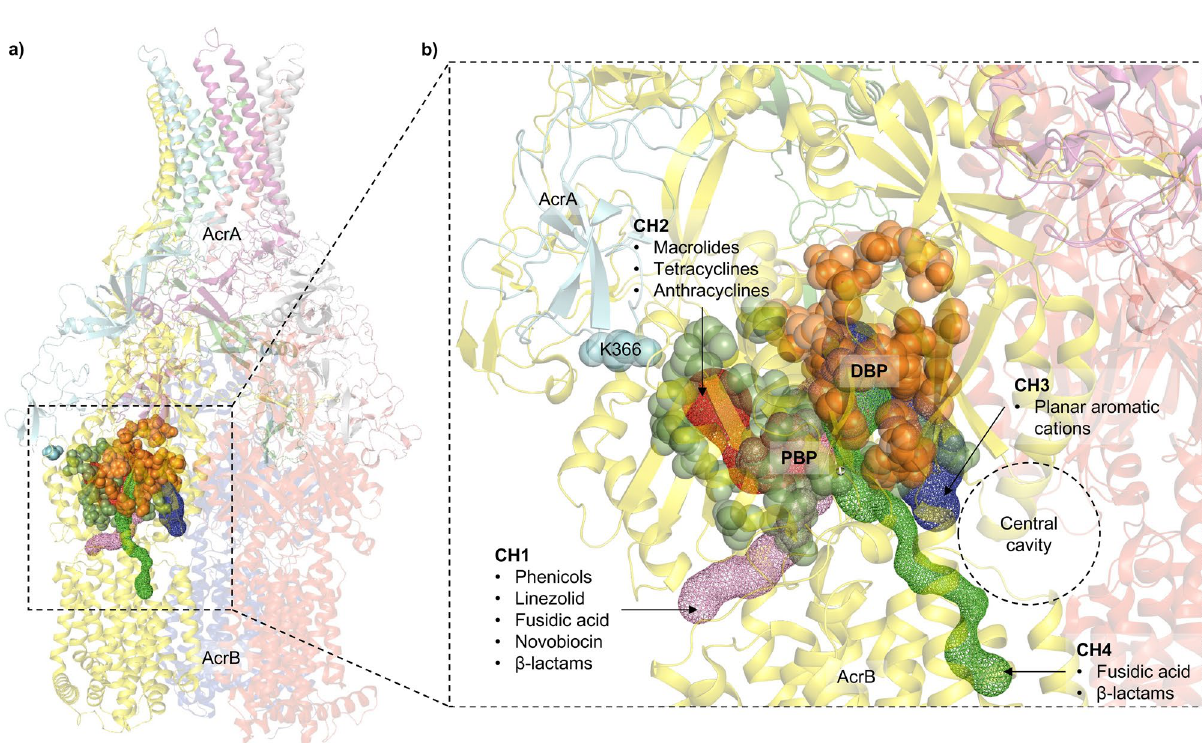
Figure 4. ( a ) The crystal structure of the trimeric AcrB transporter and the hexameric AcrA assembly (TolC not shown for clarity). The different substrate entry pathways are shown as coloured channels, and the binding pockets are indicated by coloured spheres. ( b ) Zoomed-in view of the substrate channels and the binding pockets relative to K366 of AcrA. The green and orange spheres correspond to the space-fill representation of the residues lining the proximal binding pocket (PBP) and the deep binding pocket (DBP), respectively. K366 is in the membrane-proximal domain of AcrA and impacts the residues lining the PBP and the entrance of channel 2 (CH2). Channel 1 (CH1) also feeds into the PBP, so is likely to be impacted by changes in K366. Channel 3 (CH3) starts from the central cavity and leads to the DBP. Similarly, channel 4 (CH4) starts from the groove formed by TM1/TM2 and leads to the DBP. Therefore, CH3 and CH4 are unlikely to be directly impacted by K366